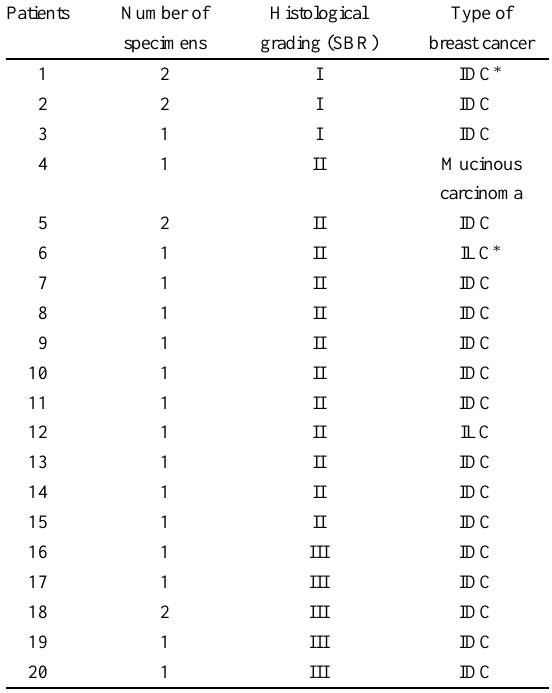
Characteristics of the twenty tumours